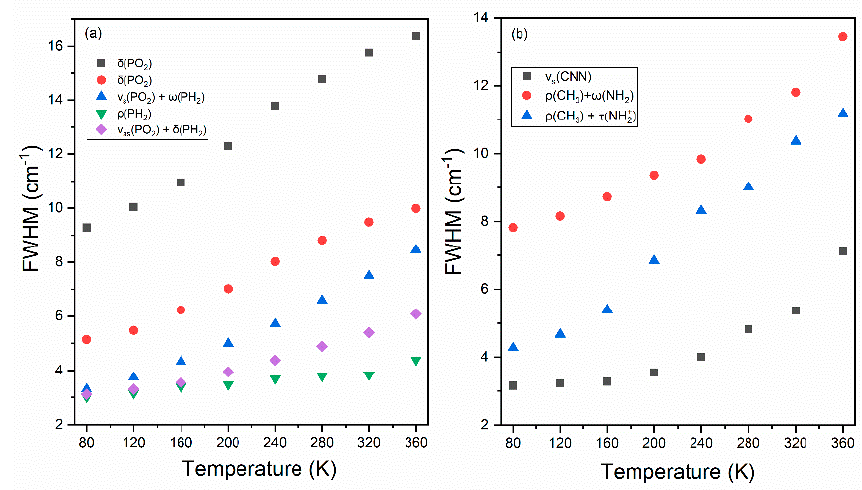
Figure 5. The temperature evolution of Raman full widths at half maximum (FWHMs) of bands corresponding to vibrations of groups that built up ( a ) H 2 PO 2 − and ( b ) MHy + ions.